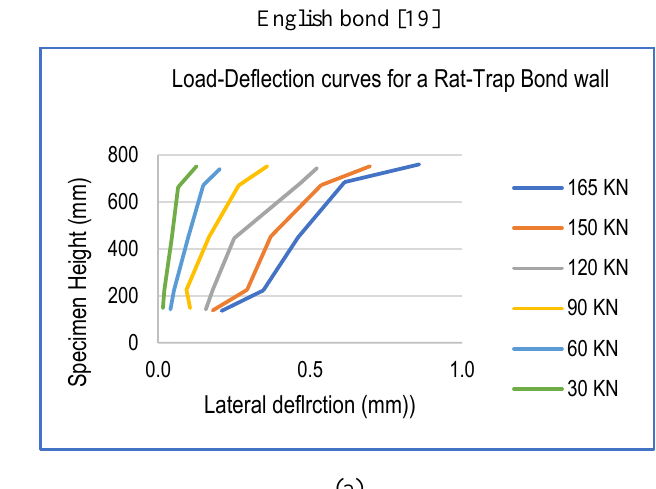
Fig. 8. Load -deflection curves for RTB, Flemish and